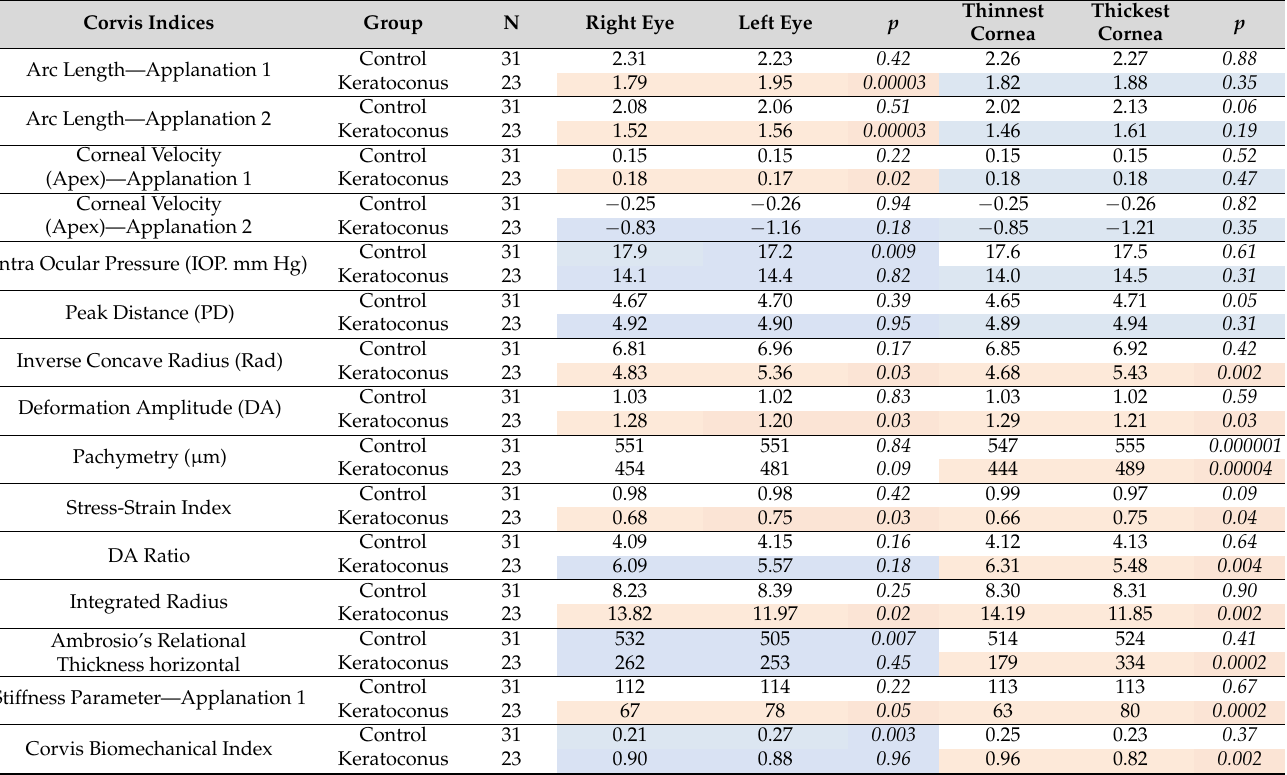
Table 2. Biomechanical enantiomorphism analysis in normal and keratoconus